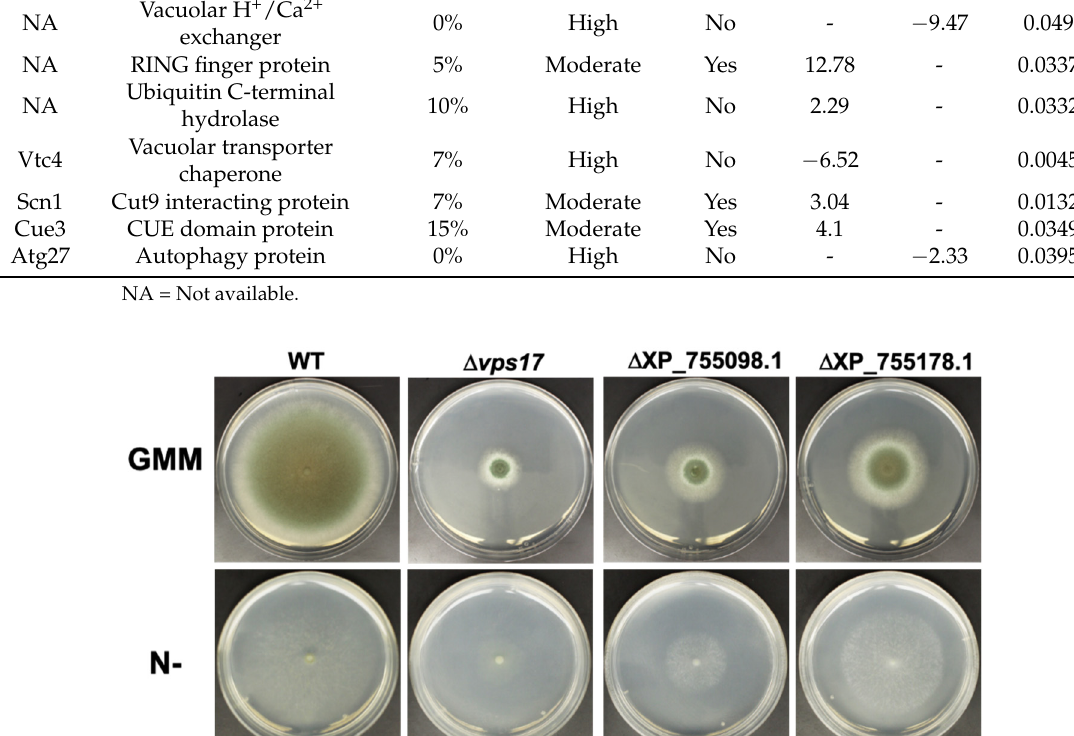
Figure 5. Deletion phenotypes of additional PKA-regulated autophagy proteins. Reduced radial growth phenotypes of Vps17 ( Δ vps17 ), putative vacuolar H + /Ca 2+ exchanger ( Δ XP_755098.1), and putative ubiquitin C-terminal hydrolase ( Δ XP_755178.1) deletion strains grown on GMM agar or nitrogen-free GMM agar (N-) for 4 days at 37 °C, compared to the wild-type (WT) strain.